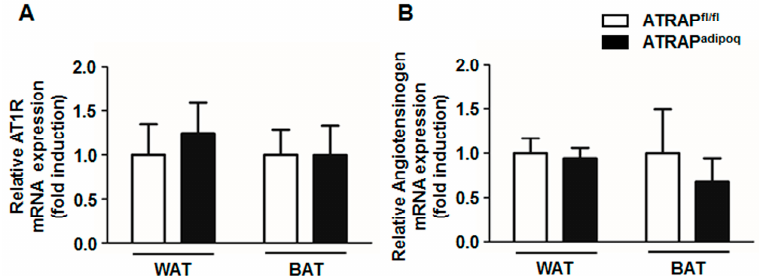
Figure 2. The relative expression of renin–angiotensin system (RAS) components in adipose tissues. Relative angiotensin II type-1 receptor (AT1R) mRNA ( A ) and angiotensinogen mRNA ( B ) expression in WAT and BAT of ATRAP fl/fl and ATRAP adipoq mice fed an LFD ( n = 5–6). Values are the means ± standard error of the mean (SEM). AT1R: Angiotensin II type1 receptor; WAT: White adipose tissue; BAT: Brown adipose tissue; LFD: Low-fat diet. Table 1. Primer sequences to generate Agtrap fl/fl and Adipoq-Cre + /Agtrap fl/fl mice.